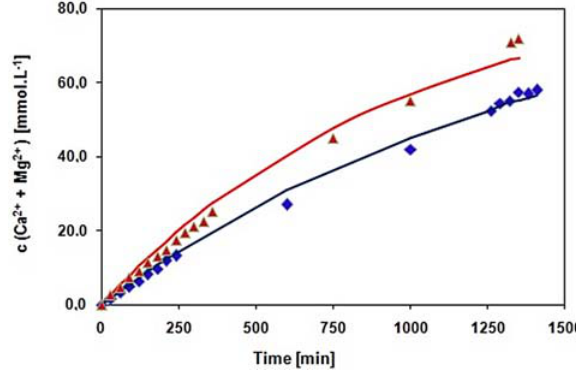
Figure 5. Time dependencies of (Ca 2+ + Mg 2+ ) content during re- Figure 4. Time dependencies of (Ca 2+ + Mg 2+ ) content during re- carbonization experiments in FBRR (Q carbonization experiments in FBRR (Q = 0 L · min –1 ): ( (cid:2) ) w = CO2 1 w 0.011 m · s –1 , ( (cid:2) ) w = 0.039 m · s –1 –experimental values (points) 2 and calculated values (lines).